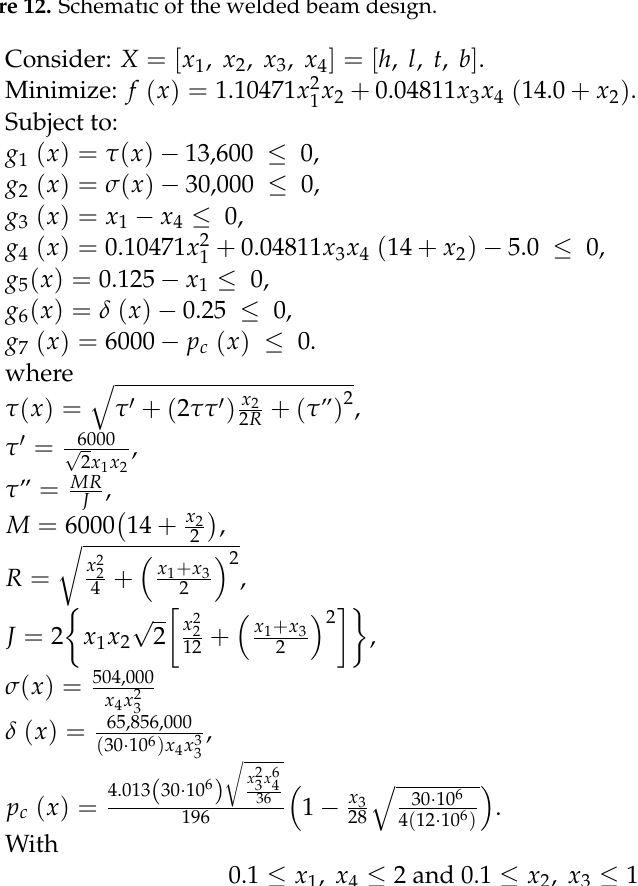
Figure 12. Schematic of the welded beam design.